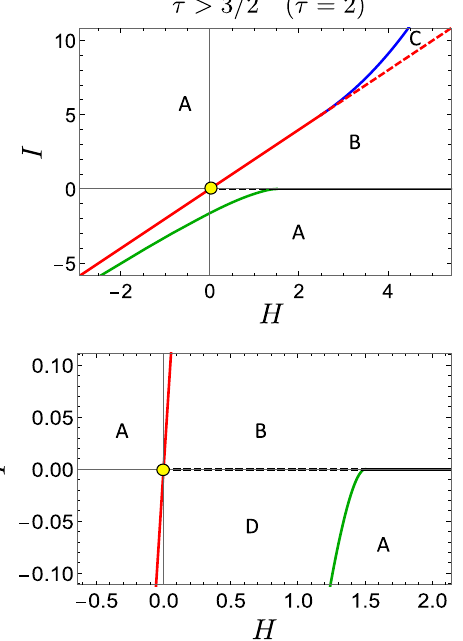
FIG. 14. Bifurcation diagram Σ for the insert strength value τ ¼ 2 , dividing the ð H; I Þ plane into five distinct regions. (Upper) Default view, showing all available regions. (Lower) Scaled-up view near ð H; I Þ ¼ ð 0 ; 0 Þ